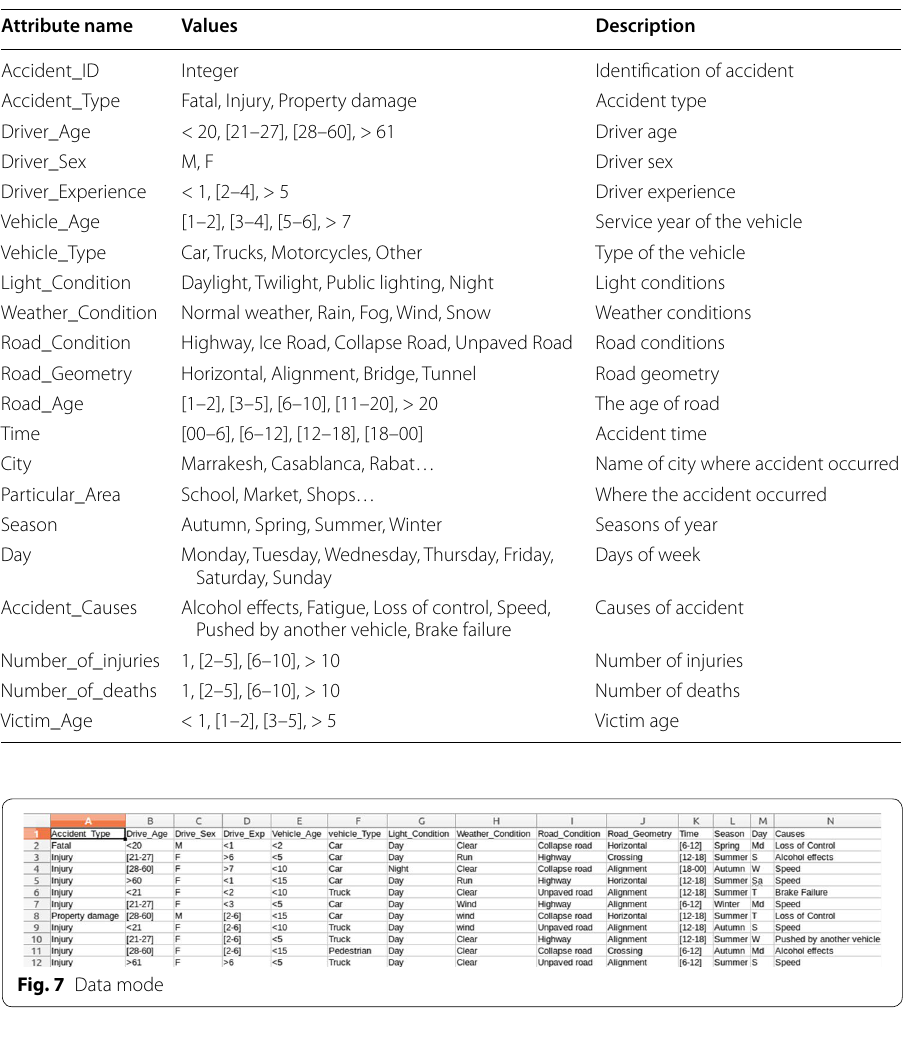
Table 3 Attributes and factors of traffic accident